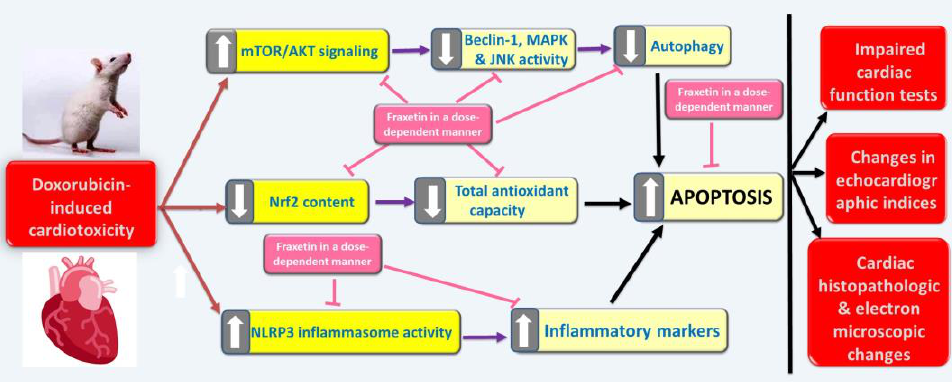
Figure 7. A diagram showing the mechanisms by which the different doses of fraxetin might combat doxorubicin-induced cardiotoxicity.